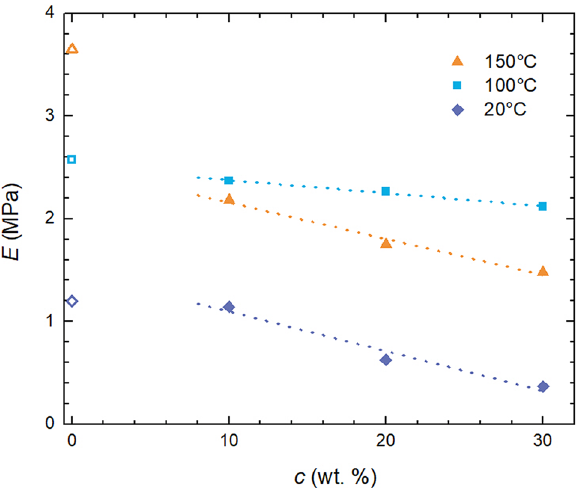
Figure 9. Impact of oil extension of Sylgard 184 on tensile modulus for various